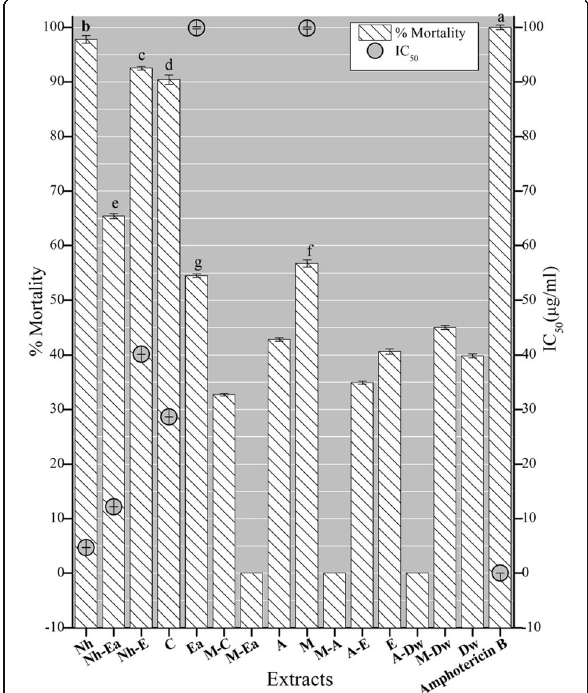
Fig. 4 Antileishmanial activity of A. bracteosa in different solvents . Extracts and the standard are tested at the concentration of 100 and 0.33 μ g/ml respectively. Values are presented as mean ± Standard deviation ( n = 3). The columns with different superscript ( a-g ) letters show significantly ( P < 0.05) different